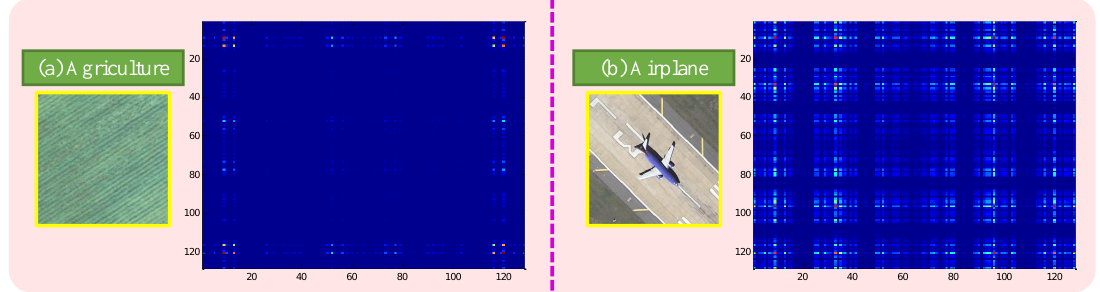
Figure 5. Two visualized examples of WCMs. The WCMs for airplane and agriculture show a distinct appearance, which means that the WCM itself has some discriminative power for representing the image scene. The highlights in WCM denote the frequent pairwise patterns of